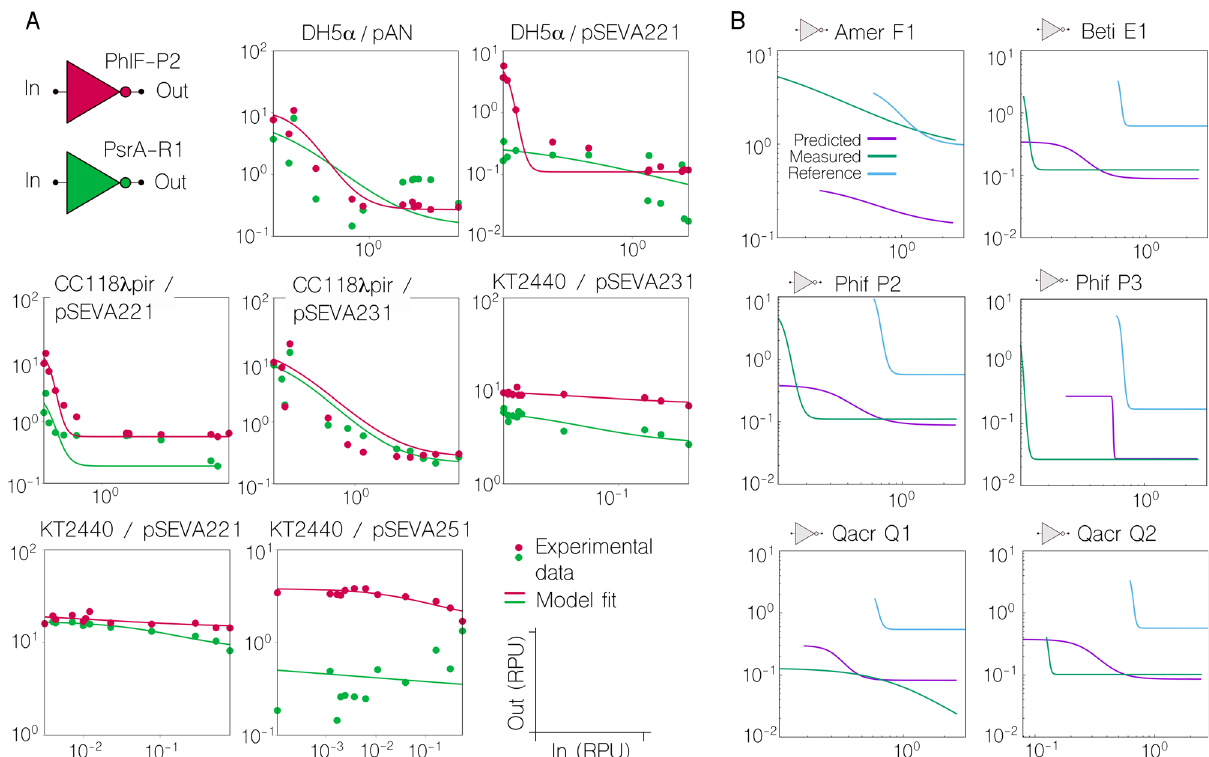
Fig. 2 Nonlinear effects in the cross-context portability of inverters. a Plots comparing the characterisation of two gates, PsrA-R1 and PhIF-P2, in different contexts. As well as each individual characterisation is differing across contexts, the relationship between the two characterisations also differs, depending on both strain and plasmid. This is, some contextual changes impact on a similar way on the performance of two inverters, while others impact on a different way — what we refer to as nonlinear modi fi cations. b Nonlinearities made the prediction of gate performance changes between contexts an overarching challenge. Predictions were made for gates in the E. coli DH5 α (pSEVA221) context ( ‘ Predicted ’ line), based on their characterisations in E. coli CC118 λ pir (pSEVA221) i.e. ‘ Reference ’ line. Predictions were made using a transformation matrix found by searching for the optimal linear transformation between the AmtR-A1 gates in each context. The actual characterisation of the gate is shown for comparison ( ‘ Measured ’ line). It can be seen that the optimised linear transformations cannot accurately predict changes in gate behaviour between contexts. In particular, although translations (a linear transformation) in the Input and Output axis appear to be predicted well in some cases (see for example QacR Q2), more qualitative changes in the shape of the response curve cannot be addressed by this linear transformation (see for example QacR-Q1). All response curves are plotted in